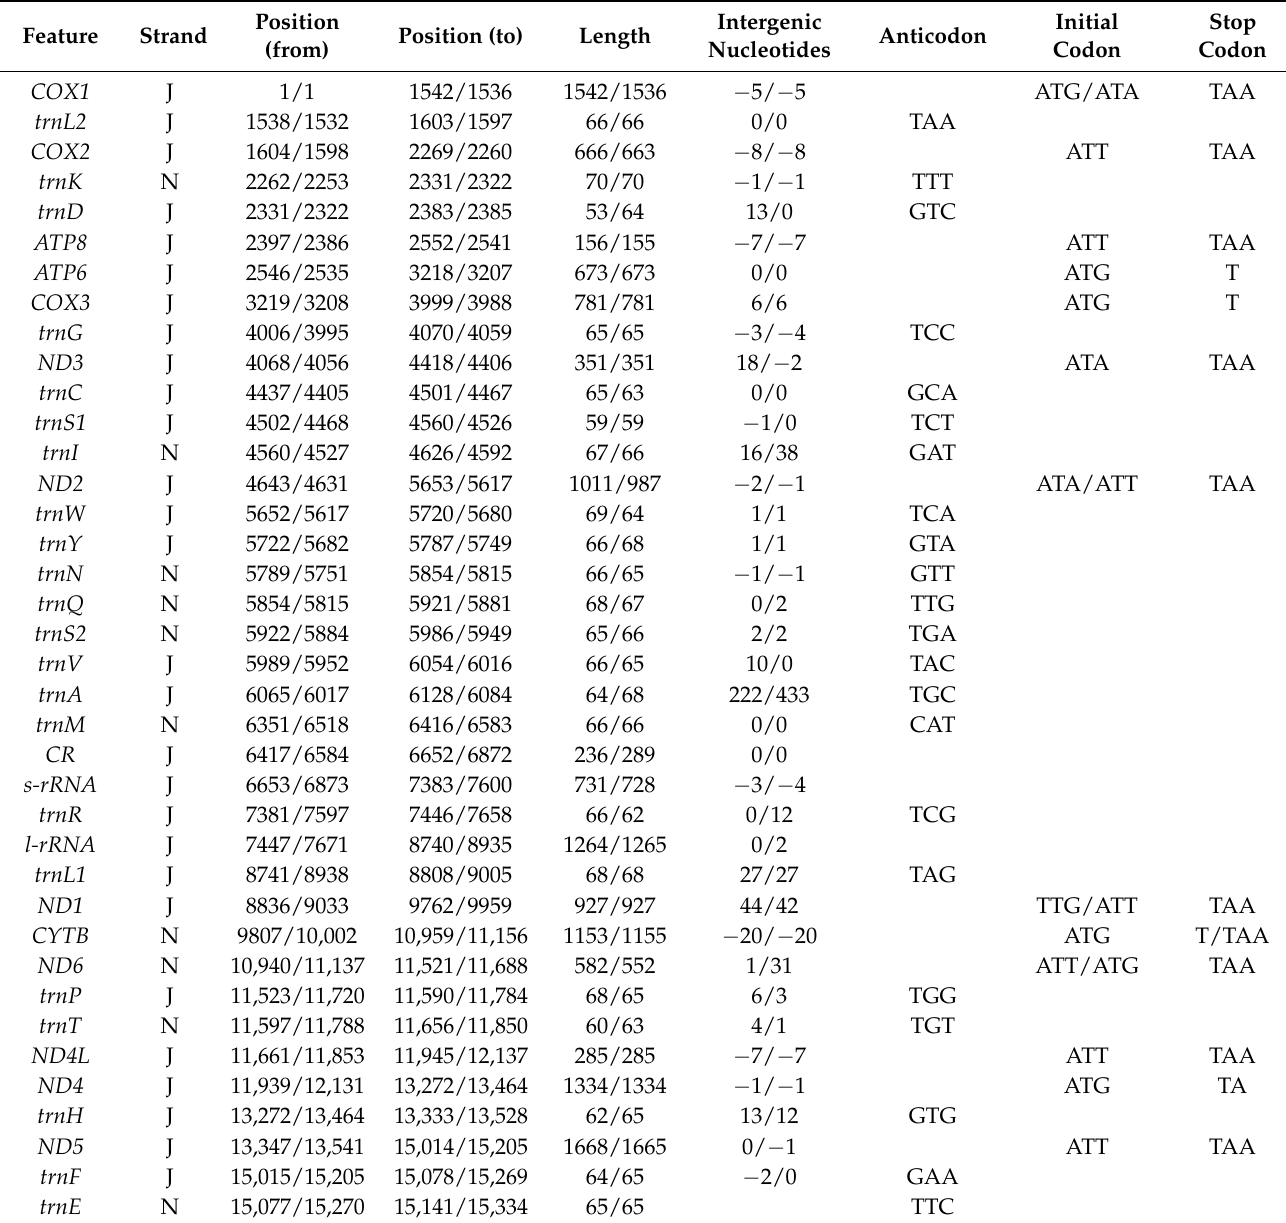
Table 2. Features of the mitogenomes of B. lasus (left) and H. nipponensis